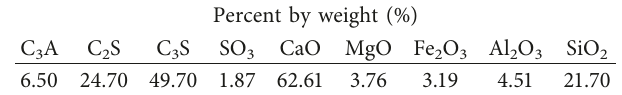
Figure 2: Grading curve of fine aggregates. Table 1: Chemical properties of cement.